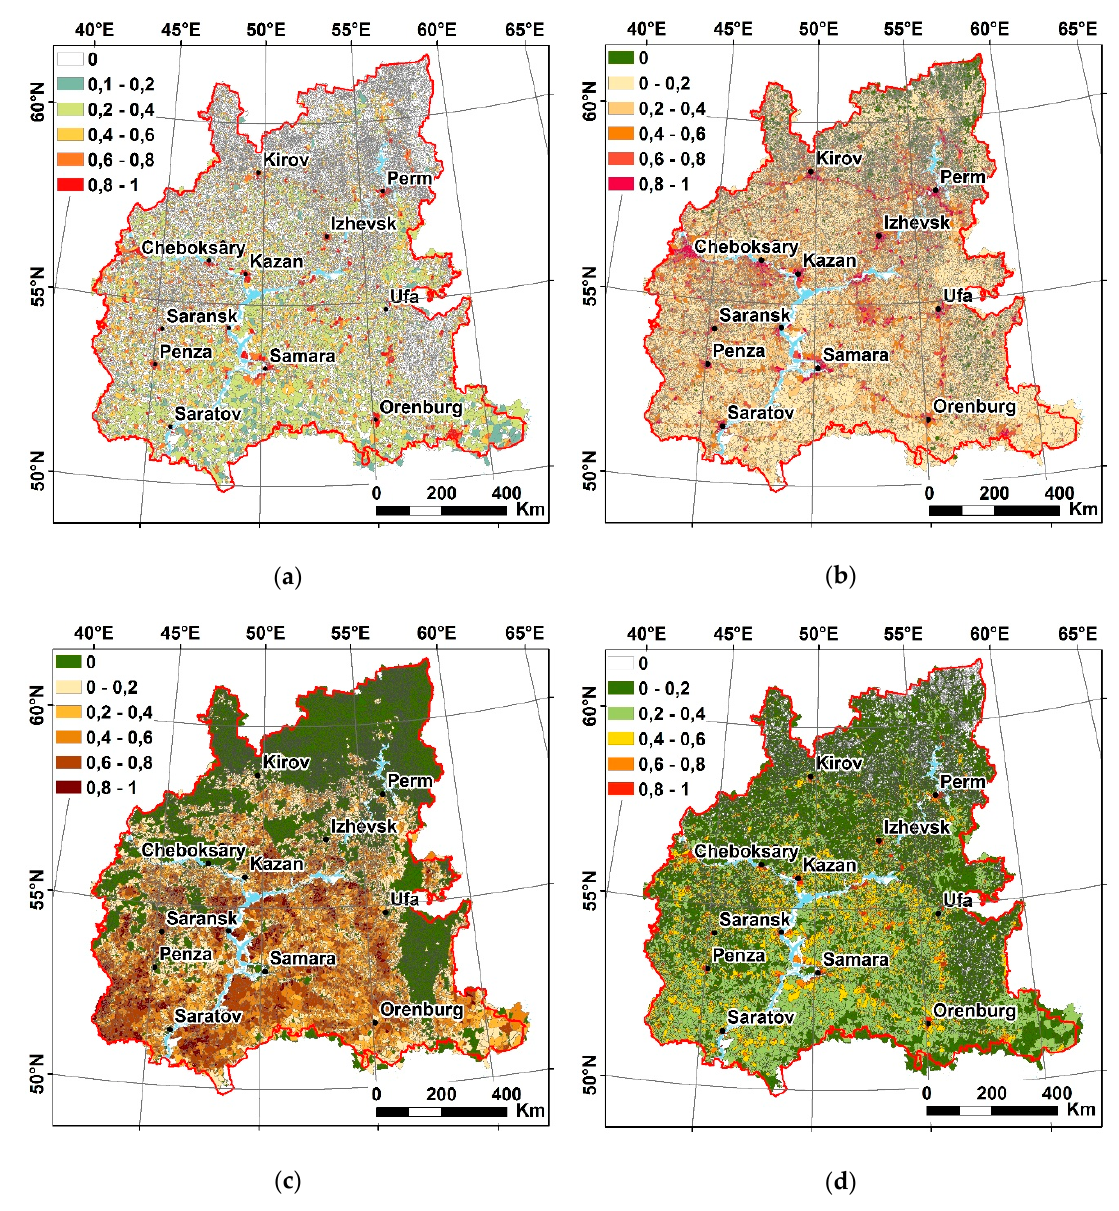
Figure 8. Maps of particular and integral indicators of anthropogenic pressure in the river basins of the Volga Federal District: ( a ) the normalized indicator of population density, ( b ) the normalized indicator of the density of the road network, ( c ) cropland fraction in the river basins, ( d ) integral indicator of anthropogenic pressure in the river basins.